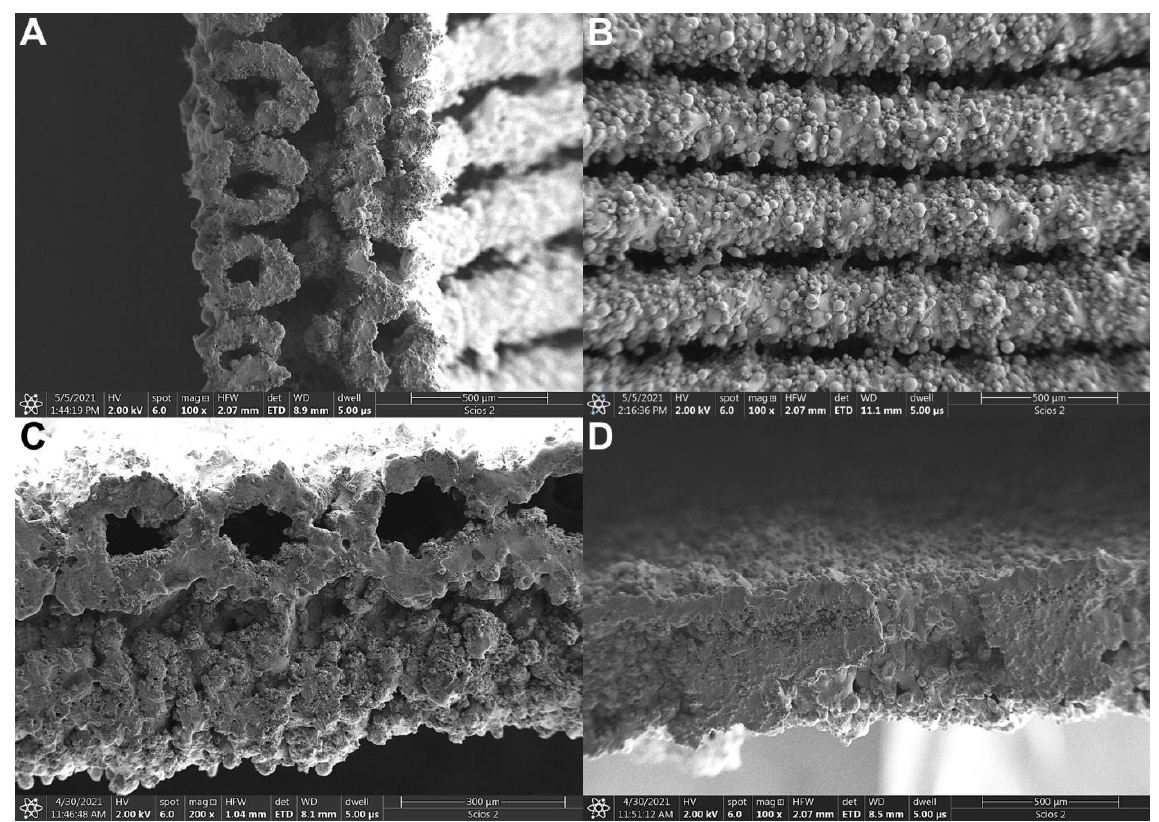
Figure 3. SEM images of the ( A , B ) longitudinal section and ( C , D ) cross-section of printed, engineered object based on the design of frustule of Didymosphenia geminata before compression test. Images of the ( A ) section of the ribs, ( B ) ribs from the interior view, ( C , D ) various construction of the wall. Table 3. The mean values with standard deviation of the 3D printed engineered object (according to the designation in Figures 2 and 4) before and after compression testing.